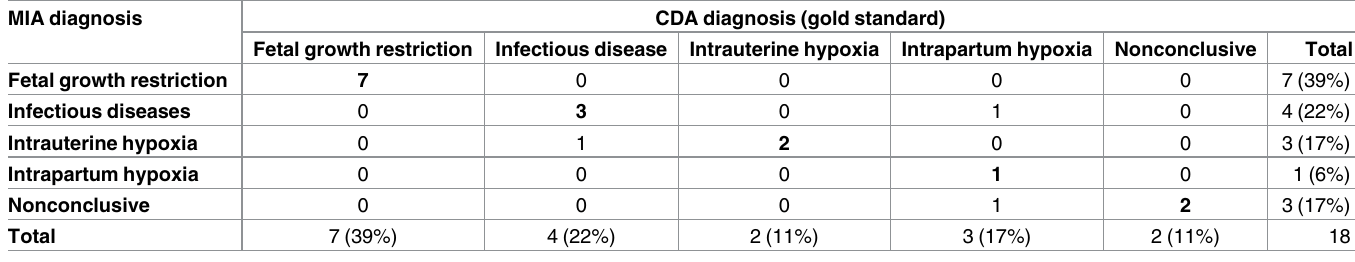
Kappa value = 0.78, 95% CI